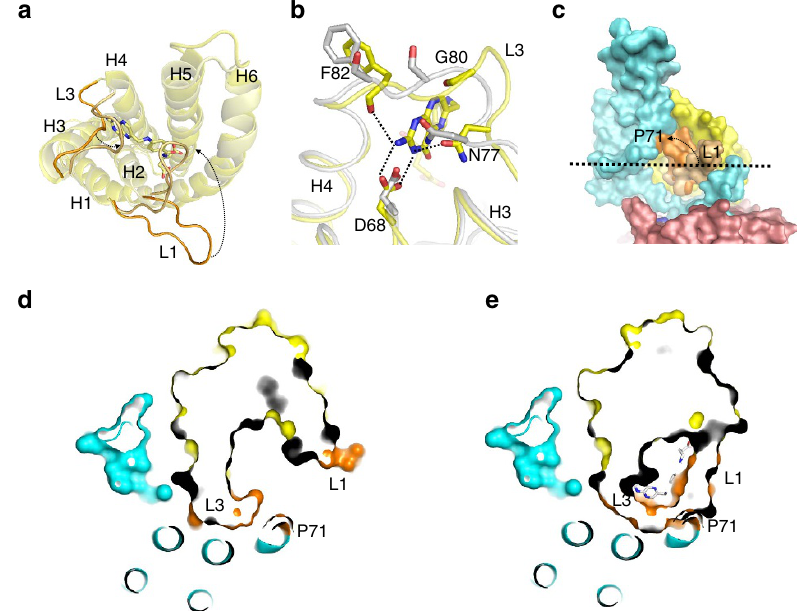
Figure 4 | Comparison of folate-bound FolT1 and substrate-free FolT2. ( a ) Structural alignment of folate-bound FolT1 (pale yellow) and substrate-free FolT2 (bright yellow). The viewpoint is from the extracytoplasmic side of the membrane. The carbon atoms of folate are shown in pale yellow and loops L1 and L3 are coloured in pale and bright orange for FolT1 and FolT2, respectively. ( b ) Repositioning of loop L3 of FolT2 (grey) compared with FolT1 (yellow) disrupts the interactions with folate, of which the carbon atoms are coloured yellow. Binding-site residues are indicated using the one-letter code for amino acids. ( c ) Surface representation showing how loop L1 (orange) of substrate-bound FolT1 would clash with P71 (orange) of EcfTwhen forming a complex with the ECF module. Loop L1 of FolT2 is shown in pale orange for comparison. The dashed arrow shows the movement of loop L1 between FolT2 and substrate-bound FolT1. ( d ) Slice-through representation of ECF–FolT2 at the level of the dashed line in c . FolT2 is shown in surface representation with loops L1 and L3 in orange, and P71 of EcfT in orange surface representation. ( e ) The same slice as shown in d but with substrate-bound FolT1 replacing FolT2, with the carbon atoms of folate shown in grey. Loops L1 and L3 would clash with P71.